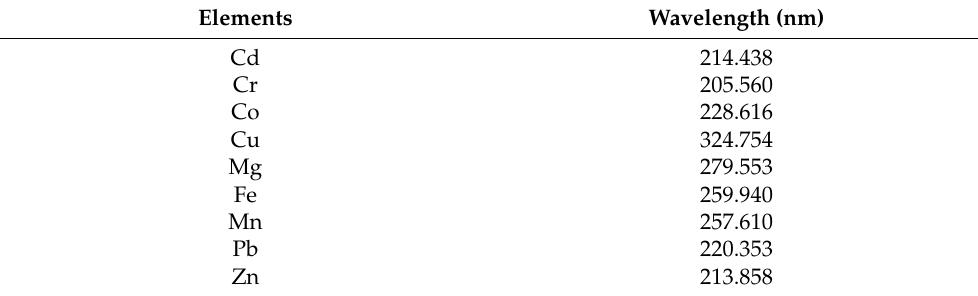
Table 1. Trace elements and their respective